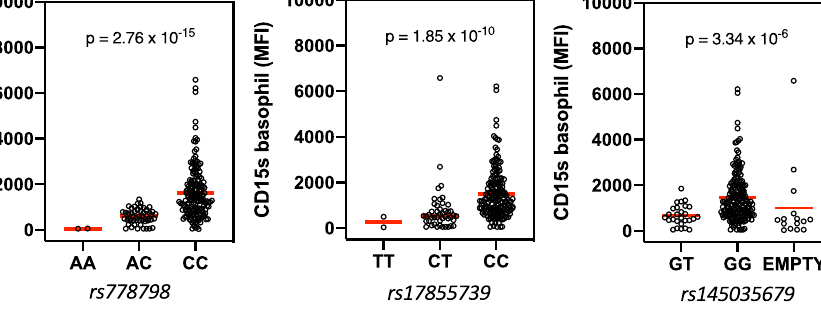
Fig. 4 Genetic control of sLe x expression on basophils. a Genome-wide pQTL correlation. PBMC samples of genotyped individuals ( n = 229) were analyzed by FACS. The Manhattan plot summarizes the association of the CD15s MFI of the basophils with the genotypes of the 2 million SNPs covered by this analysis. The x -axis represents the location of SNPs on the 22 autosomal chromosomes, the Y -axis the nominal p values ( − log10) of their association with CD15s. A clear association was observed for SNPs on chromosome 19, which are all located proximal to the FUT6 gene. b FUT6 gene locus. The upper part of the fi gure displays the location of intron and exon elements of FUT6 and neighboring genes together with the density of H3K27Ac marks. The lower part indicates the location of some of the top SNPs identi fi ed in the Manhattan plot. They are arranged into two independent linkage blocks rs778798-LB and rs17855739-LB ( r 2 < 0.05, D ’ = 1). rs778804-LB comprises only of non-coding SNPs (rs778798, rs778804, rs1531616, rs1678852, rs199921063, and rs3763045) while rs17855739-LB has also two coding SNPs (rs17855739 and rs145035679). Closely linked SNPs are connected by a horizontal line; the genetic linkage is indicated ( r 2 and D ’ ); complete list of SNPs is displayed in Supplementary Data 1. c Genotype/phenotype association. The dot plots show the association of the CD15s MFI on basophils with the genotypes of rs778798 AA ( n = 2), AC ( n = 53), CC ( n = 164), and the two coding SNPs rs17855739 (E 247 → K) TT ( n = 2), CT ( n = 45), CC ( n = 173), and rs145035679 (Y 315 → stop) GT ( n = 27), GG ( n = 183), EMPTY ( n = 15). Each dot represents one individual, p values are indicated. Plots were generated with the data collected for individuals of Chinese ethnicity from the SSIC cohort 21,22 . Signi fi cance was determined by Kruskal – Wallis